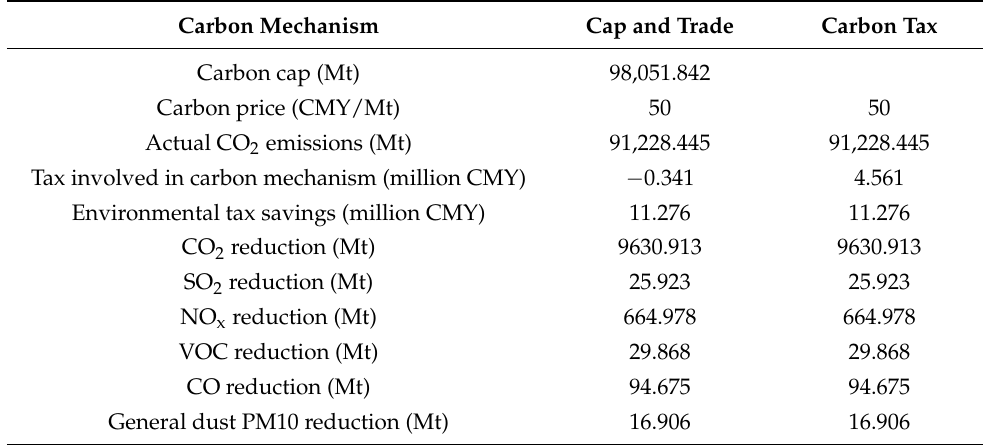
Table 7. Comparison of the impact of time-proportional on environmental benefits to all parties under the two carbon